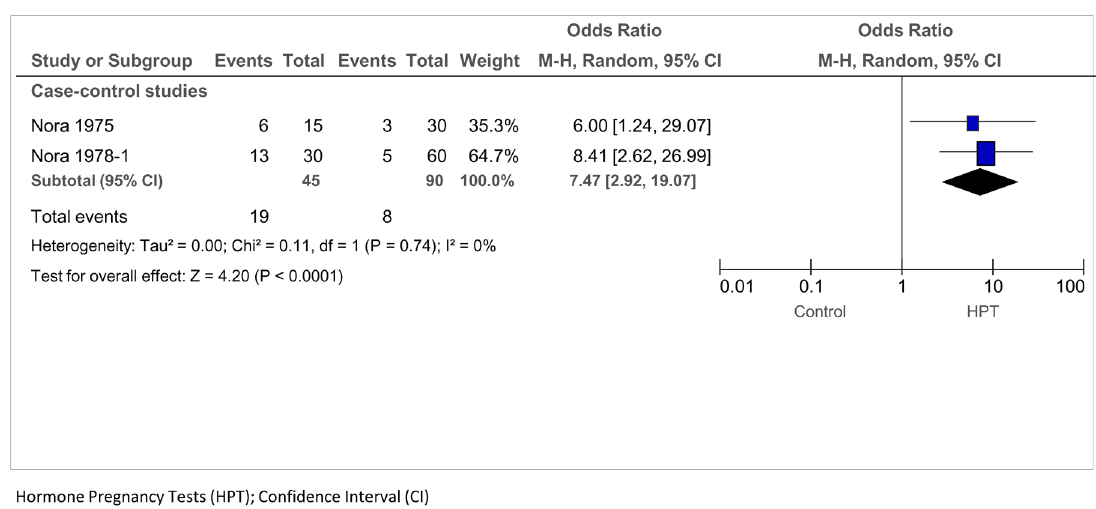
Figure 8. Association of exposure to oral hormone pregnancy tests (HPTs) in pregnancy with Vertebral defects, Anal atresia, Cardiovascular anomalies, Tracheoesophageal fistula, Esophageal atresia, Renal anomalies, and Limb defects (VACTERL) syndrome in the